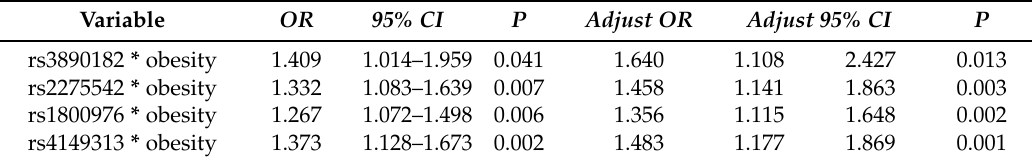
Table 5. Interactions between the ABCA1 genotypes and obesity in patients with low HDL-C.